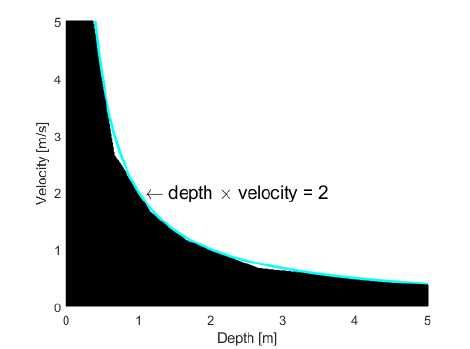
Figure 9. Polytope querying of